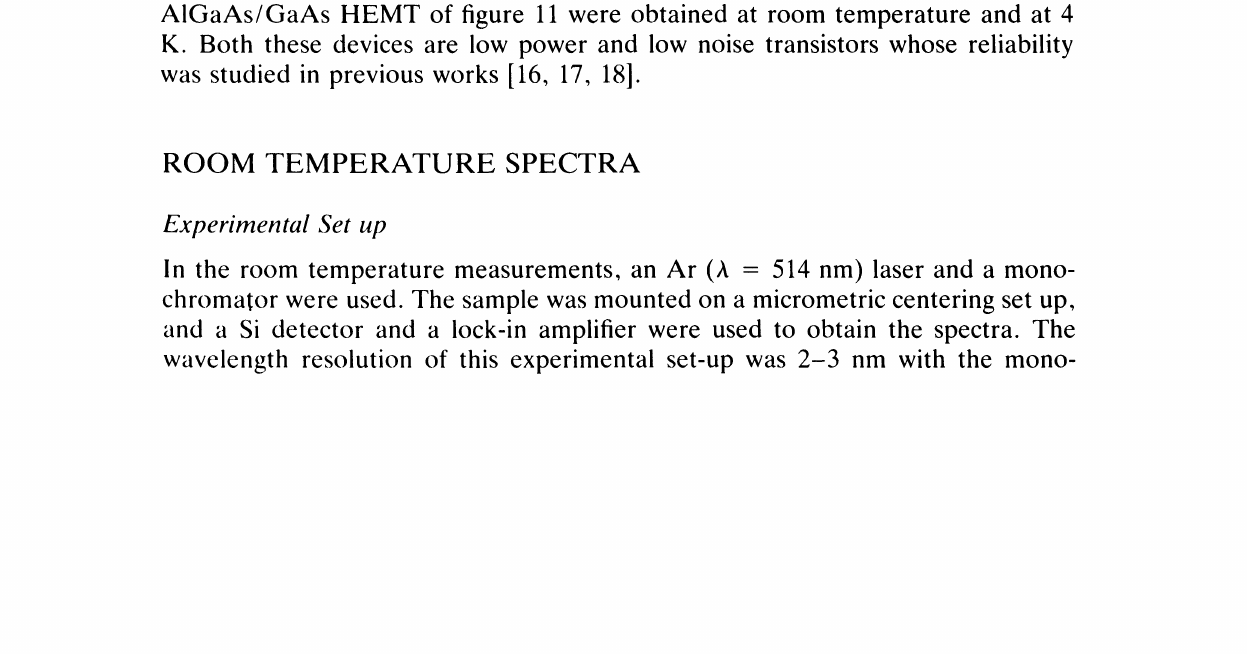
FIGURE 6 Photoluminescence spectrum of different HBTs. (From Ref.